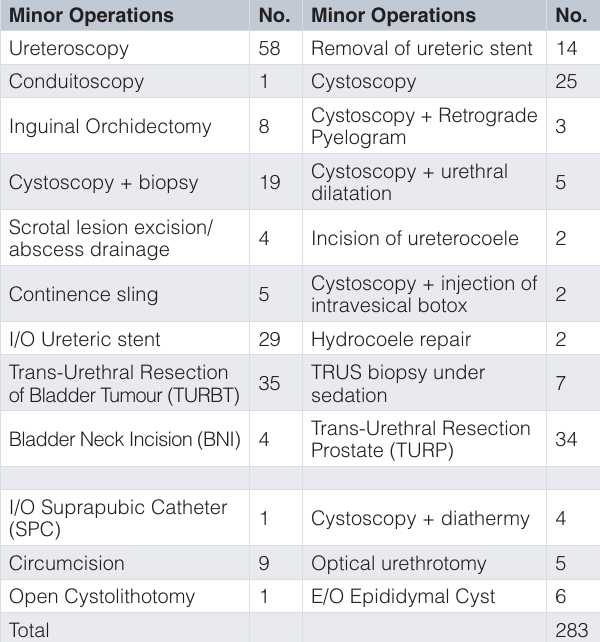
Table 3. Breakdown of minor operative procedure case-mix during the audit